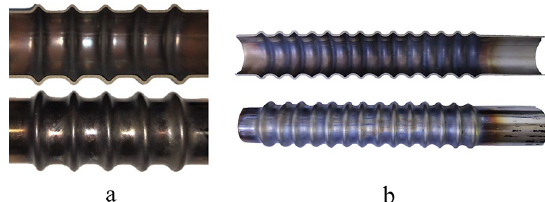
Figure 4 Formed metal bellow samples: a Discontinuous bellow, b Continuous bellow